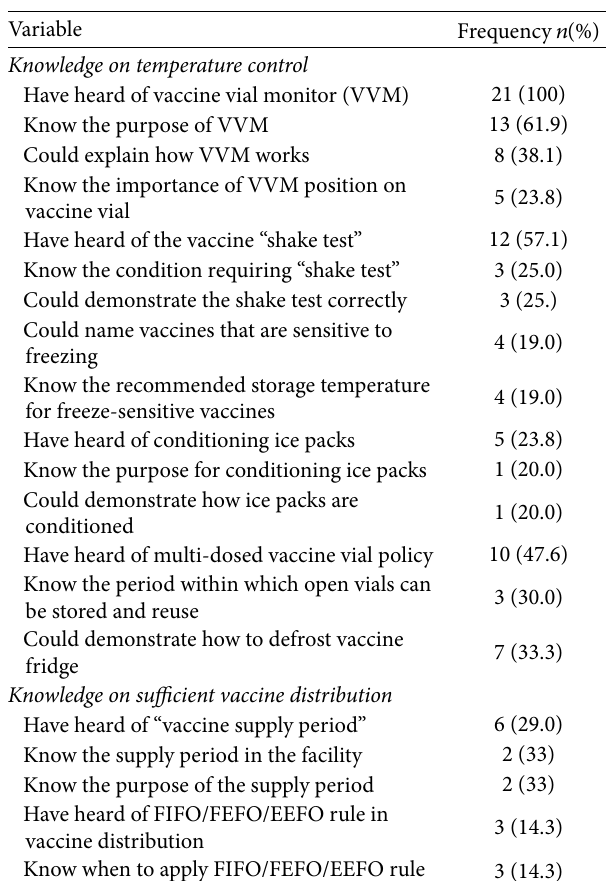
Figure 3: District average score of effective vaccine management. Table 3: Knowledge of vaccine users regarding temperature control and vaccine